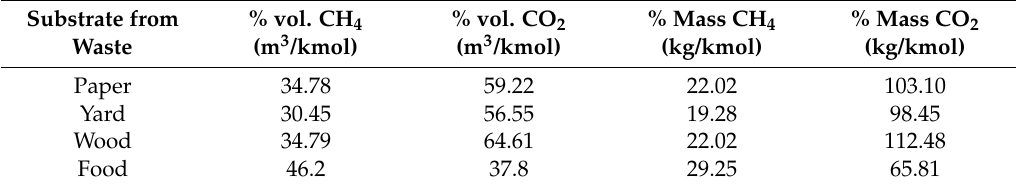
Table 3. Volumetric and mass fractions of biogas from the mesophilic anaerobic digestion of OFMSW. Substrate